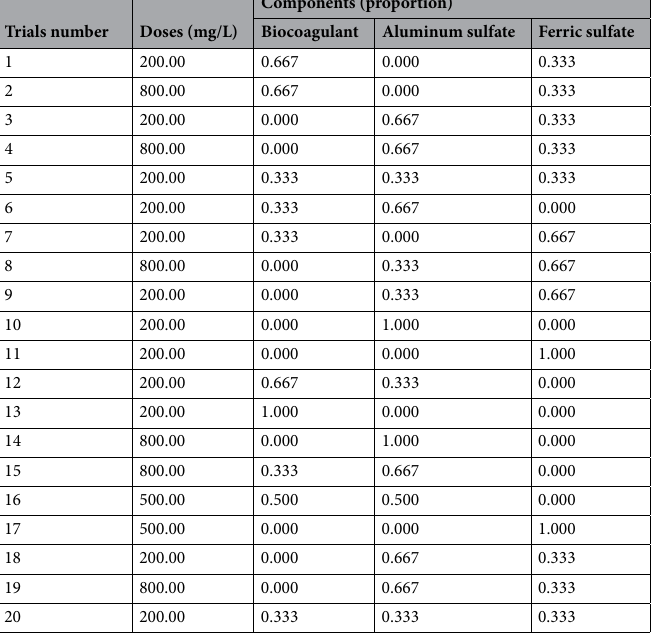
Table 1. Trials number obtained through experimental